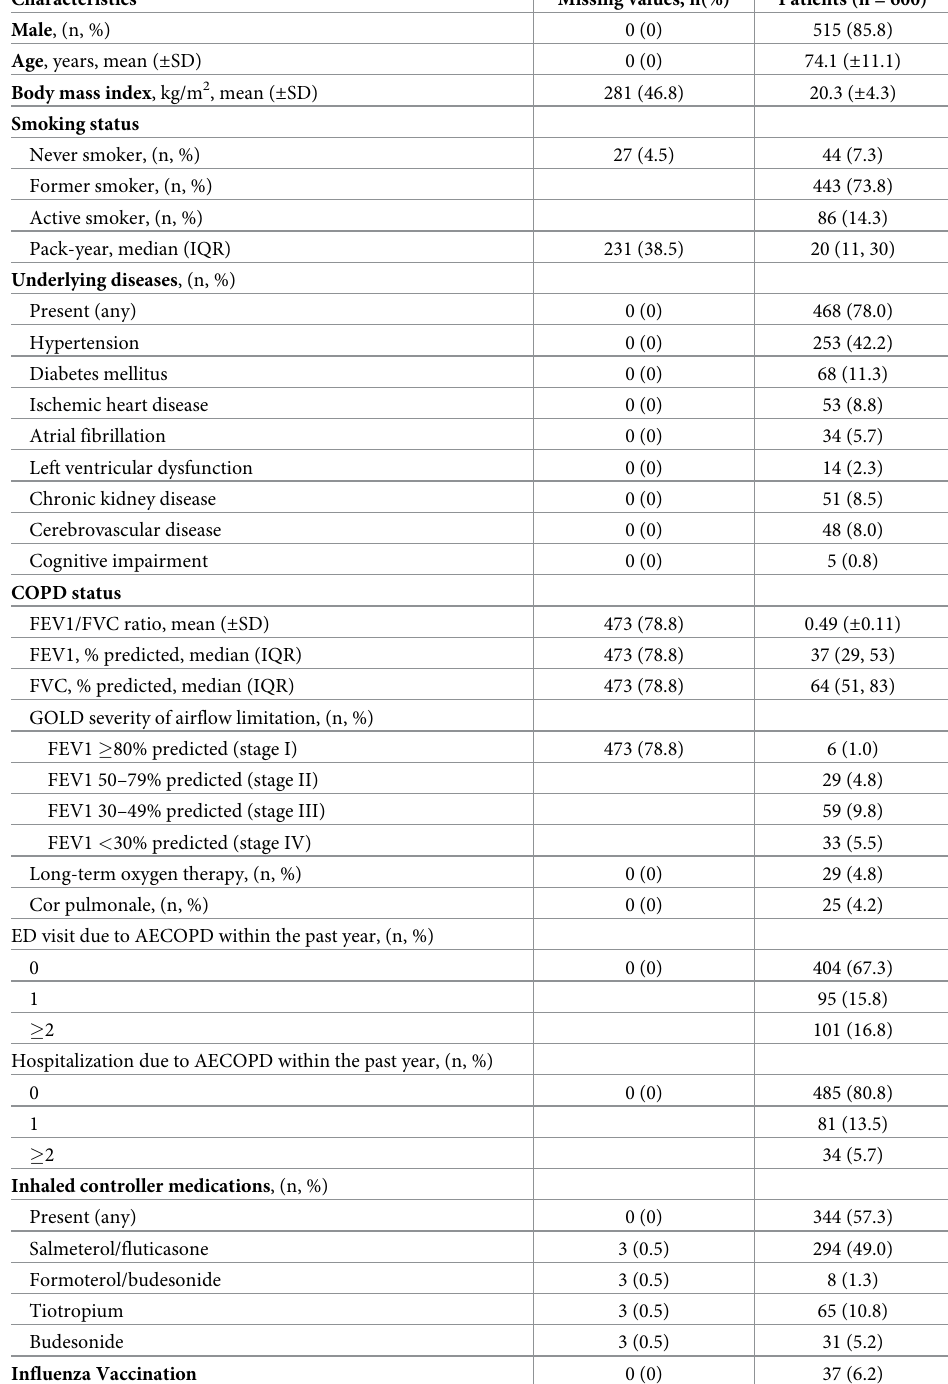
Table 1. Characteristics of COPD patients with acute exacerbation requiring hospitalization (n = 600